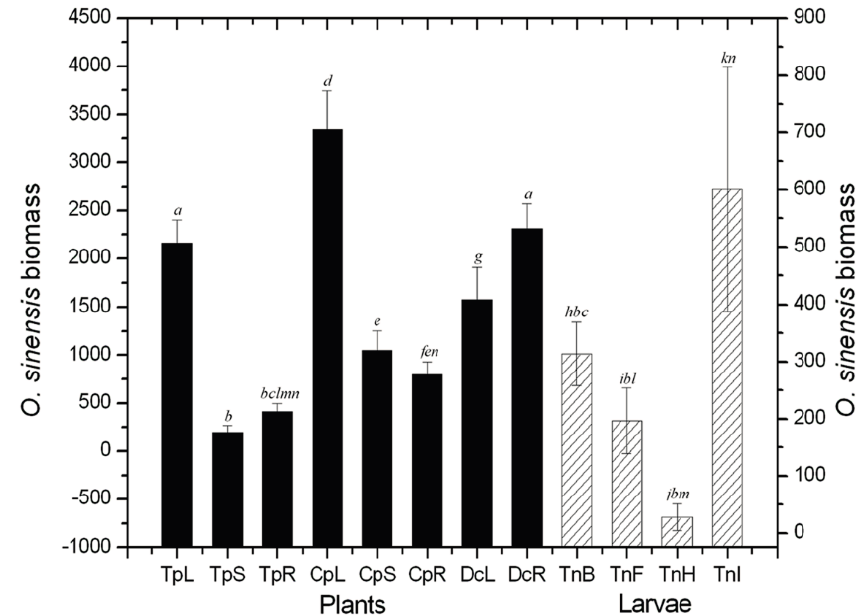
Figure 2. Biomass of O. sinensis in different tissues of the caterpillars and the dominant plants in Damxung prefecture. TpL: Trollius pumilus leaf; TpS: T. pumilus stem; TpR: T. pumilus root; CpL: Chamaesium paradoxum leaf; CpS: C. paradoxum stem; CpR: C. paradoxum root; DcL: Deschampsia caespitosa leaf; DcR: D. caespitosa root; TnB: Thitarodes namensis body-wall; TnF: T. namensis fat-body; TnH: T. namensis haemolymph; TnI: T. namensis intestinal-wall. Differences between means at p < 0.05 are indicated by different letters (bars with the same letter are not significantly